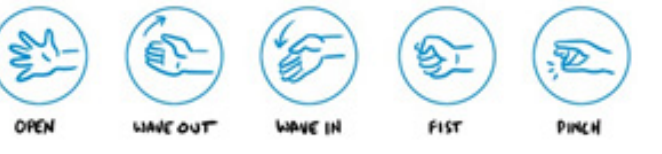
Figure 1. Gestures executed by the